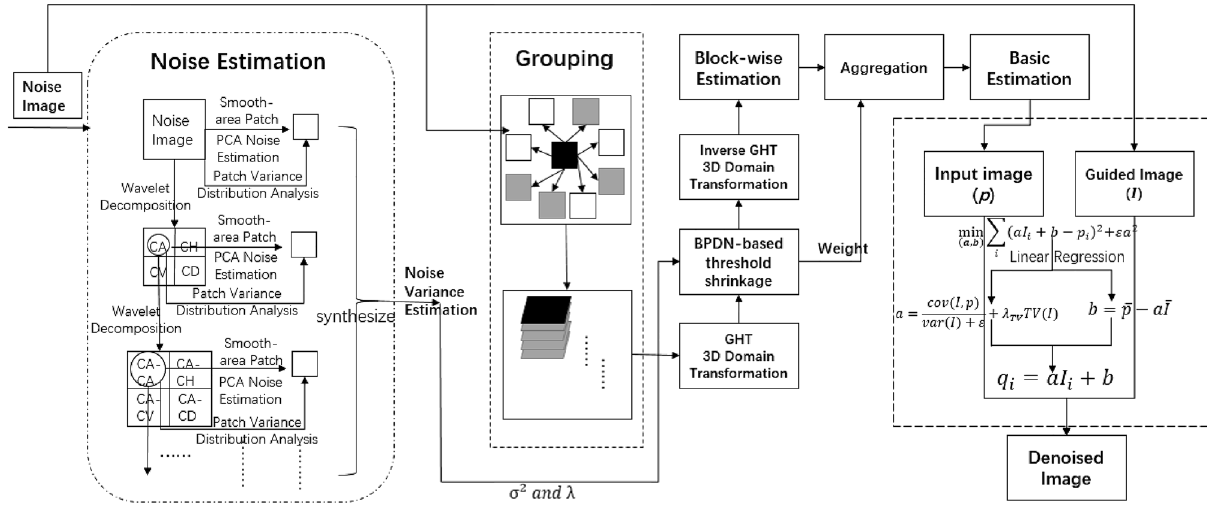
Figure 6. Flow chart of adaptive blind-noise image denoising